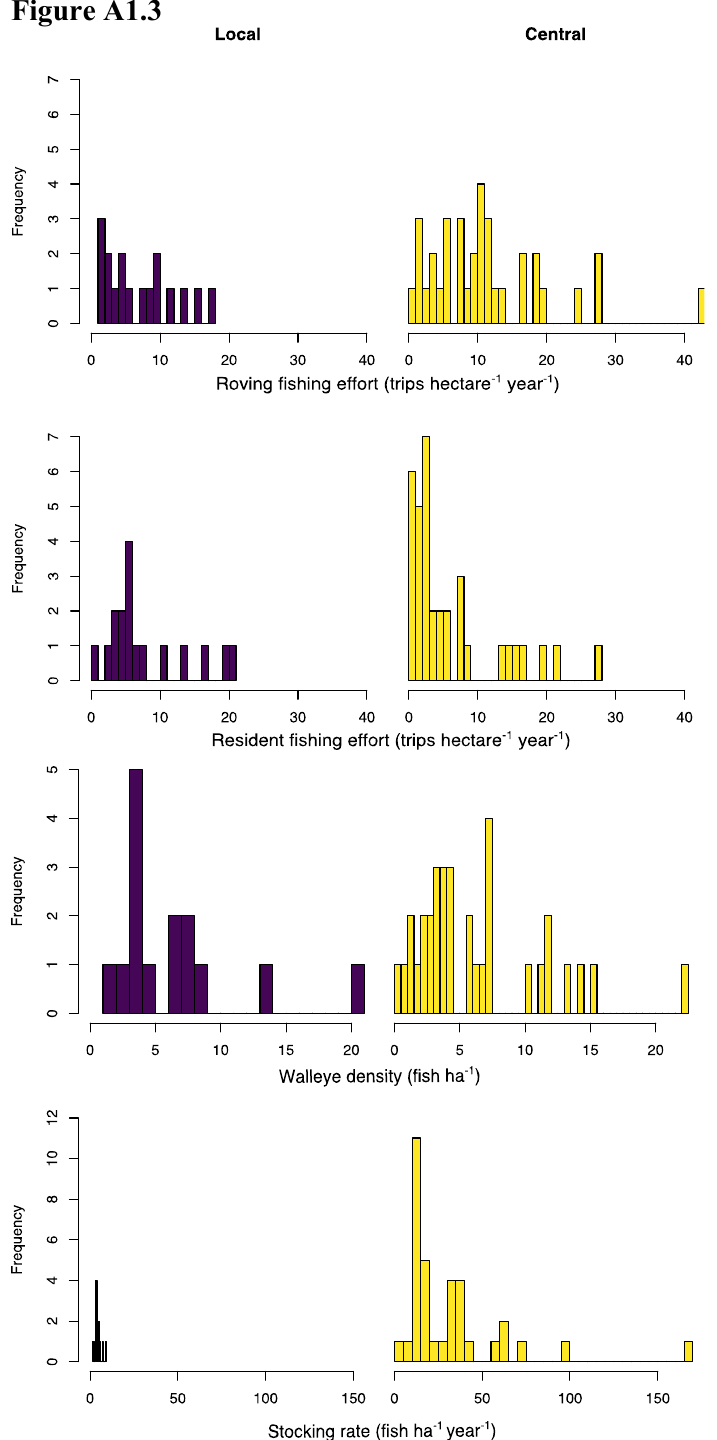
Figure A1.3. Frequency distributions of roving and resident angler effort, walleye population densities, and local and centralized stocking rates of walleye in 46 lakes in Vilas and Oneida counties, northern Wisconsin, USA. Data from Wisconsin Department of Natural Resources (DNR